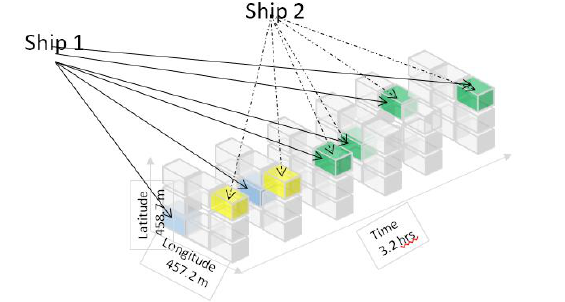
Figure 5. Co-traveling of multiple vessels for more than 3 or more time hashes and different geohashes